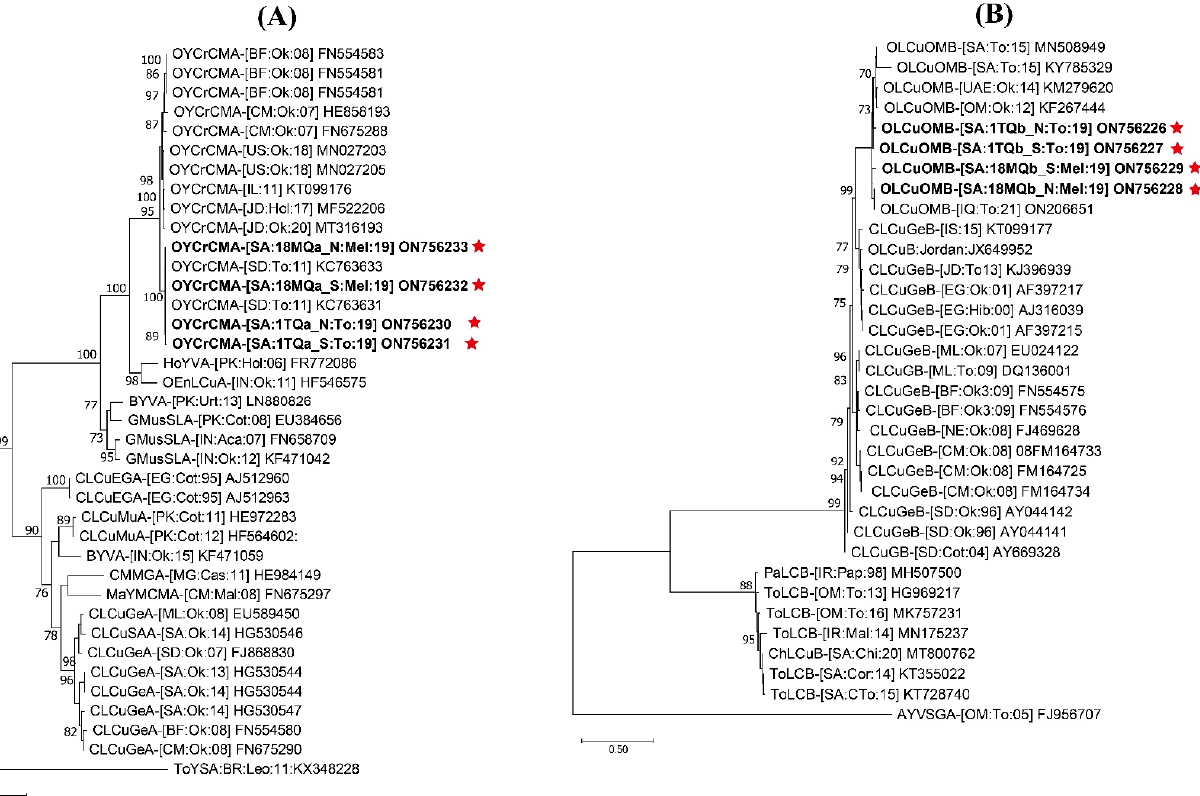
Figure 3. Maximum likelihood phylogenic dendrograms showing the evolutionary relatedness of ( A ) full ‐ length sequences of identified okra yellow crinkle Cameroon alphasatellite (OYCrCMA) and ( B ) okra leaf curl Oman betasatellite (OLCuOMB). In each case, the full ‐ length sequences of the most closely related DNA ‐ satellite sequences were retrieved from the NCBI GenBank database for comparison with the identified respective DNA ‐ satellite. The host plant species, geographical origins, and database accession numbers of each isolate used in this tree have been provided. The DNA ‐ satellite isolates identified in this study are written in bold text and indicated with a red star. The trees were constructed with percentage bootstrap values set at 1000 replicates. The guidelines suggested by Briddon et al. [6] and Briddon et al. [31] were followed for taxonomic abbreviations of